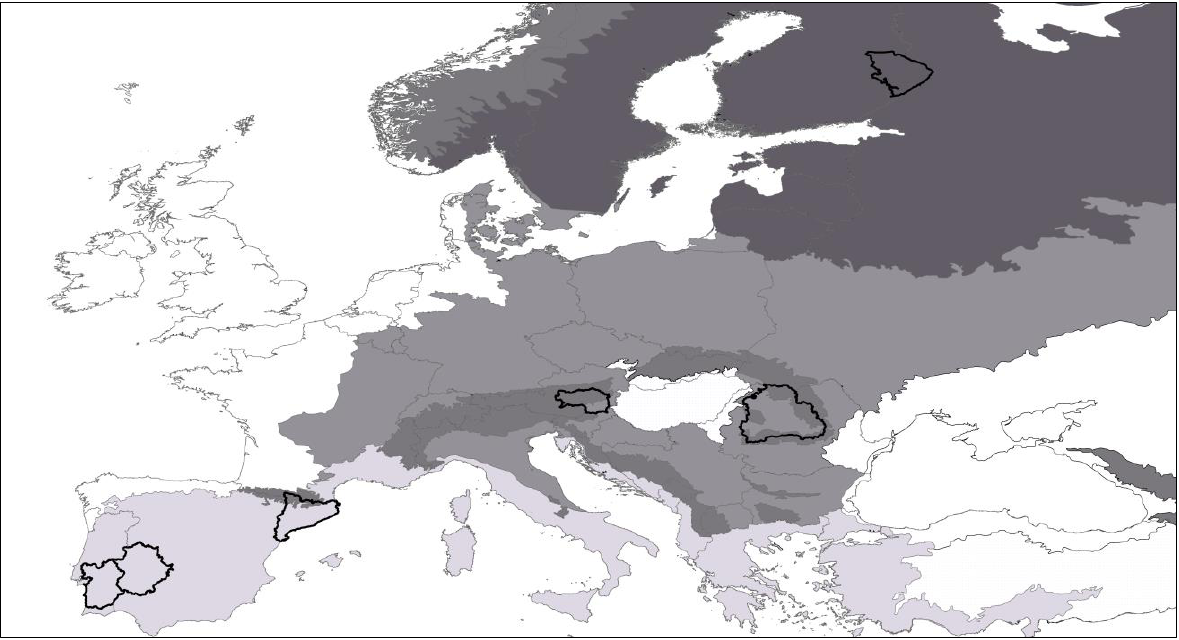
Figure 1. Overview of the case studies in Europe and related biogeographical zones. Each CS represents a distinct geographical area with diverse ecological as well as socio- economic environments. In addition to different climatic conditions, the CSs comprise various forest ecosystems, including different regional key tree species as well as varying ownership structures (Table 1). To provide some context information for the CS